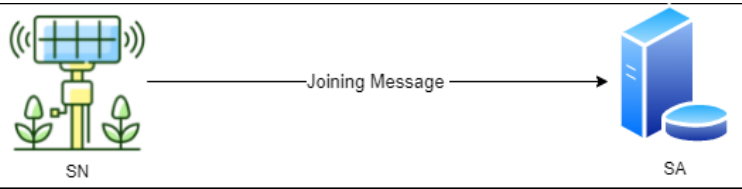
Figure 7. Newly joined sensors